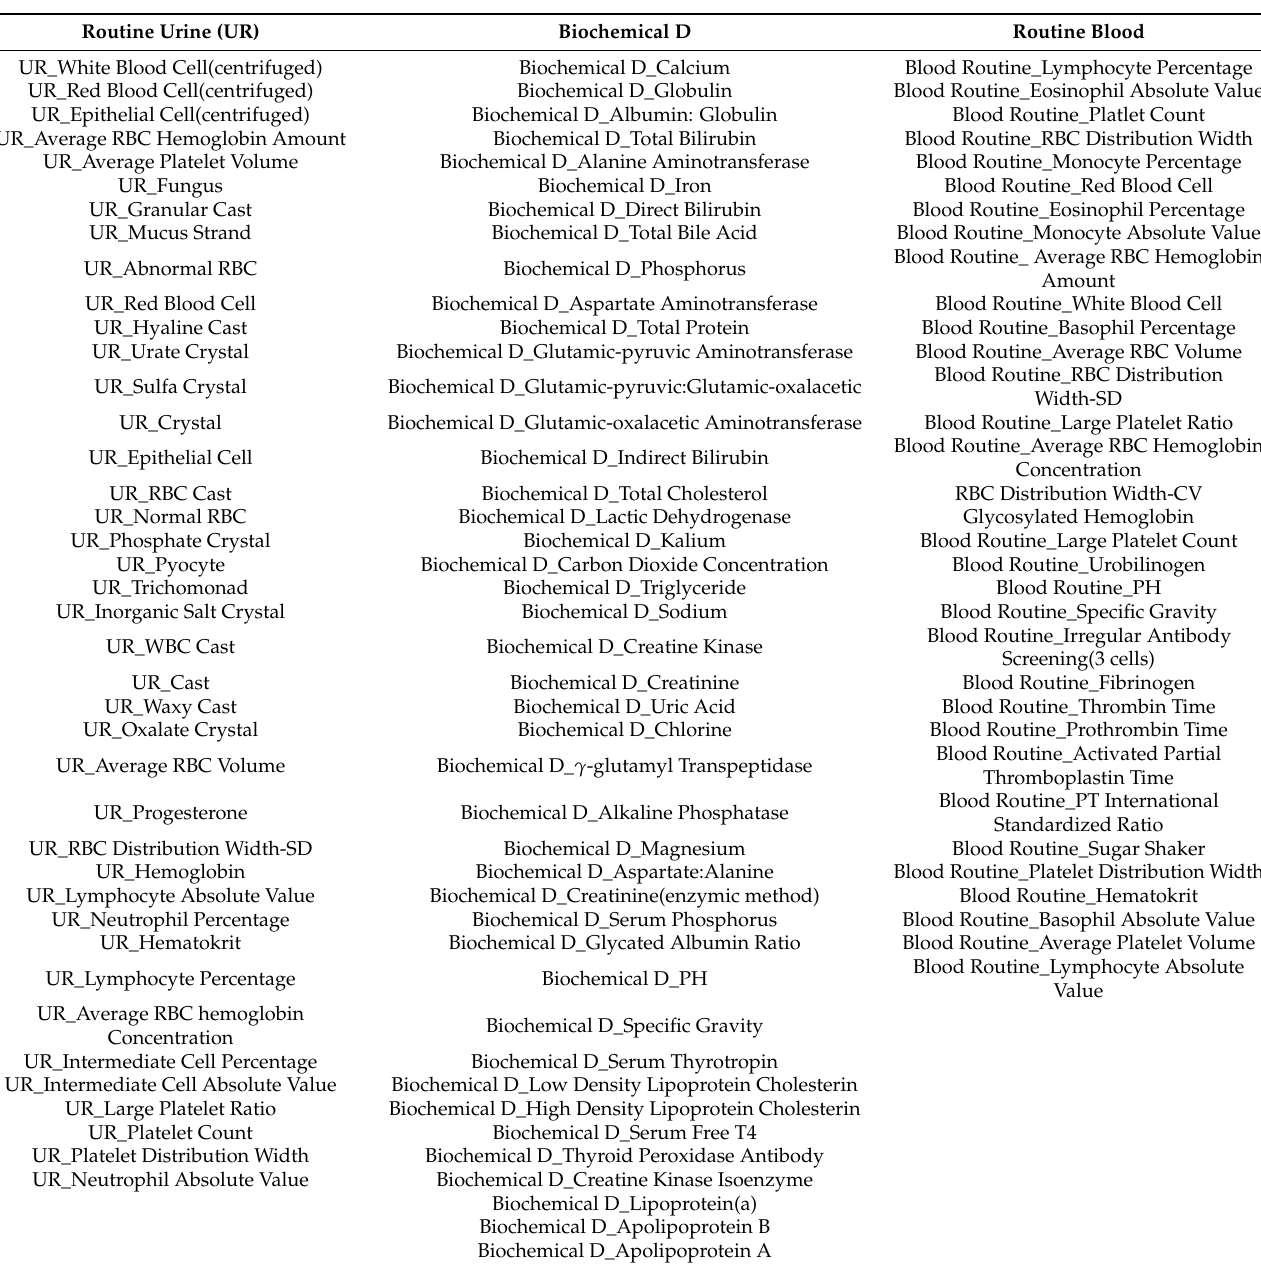
Table A1. Indicators of routine blood, routine urine and biochemical D